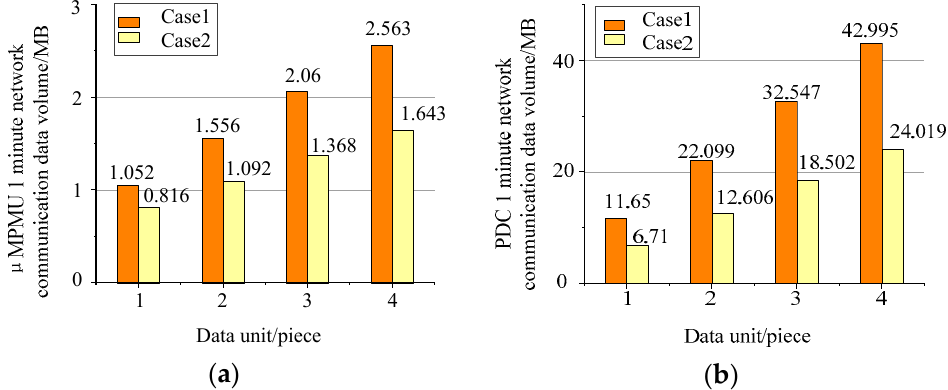
Figure 12. ( a ) Single µ MPMU 1 min network communication data amount; ( b ) single PDC 1 min network communication data amount.